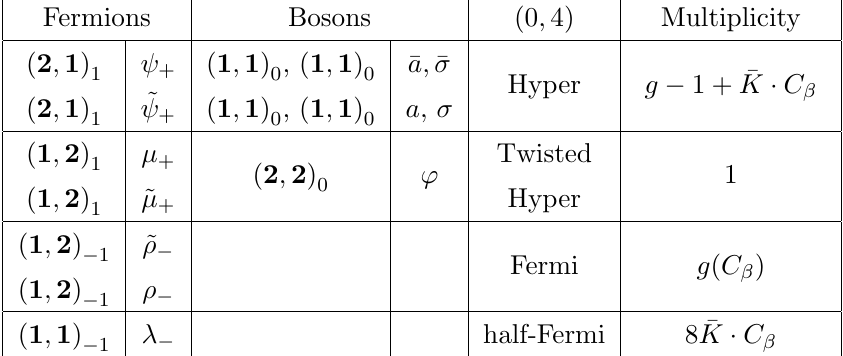
and the spectrum organizes into (0 ; 4) supermultiplets distinguished by their SU(2) (cid:2) + SU(2) quantum numbers, as well as by their spin with respect to the SO(1 ; 1) Lorentz (cid:0) algebra along the string world-sheet. The (cid:12)elds shown in the (cid:12)rst three rows of table 1 arise from dimensional reduction of the underlying N = 4 supermultiplet, while the half-Fermi multiplets in the last line localize at the intersection of C with the discriminant divisor (cid:6). (cid:12) While the naive number of such half-Fermi multiplets would be 12 (cid:22) K (cid:1) C given that (cid:6) is (cid:12) in the class of 12 (cid:22) K , not all of these modes are independent due to SL(2 ; Z ) monodromies. The correct counting is 8 (cid:22) K (cid:1) C and can be deduced [41, 42] e.g. from the requirement (cid:12)